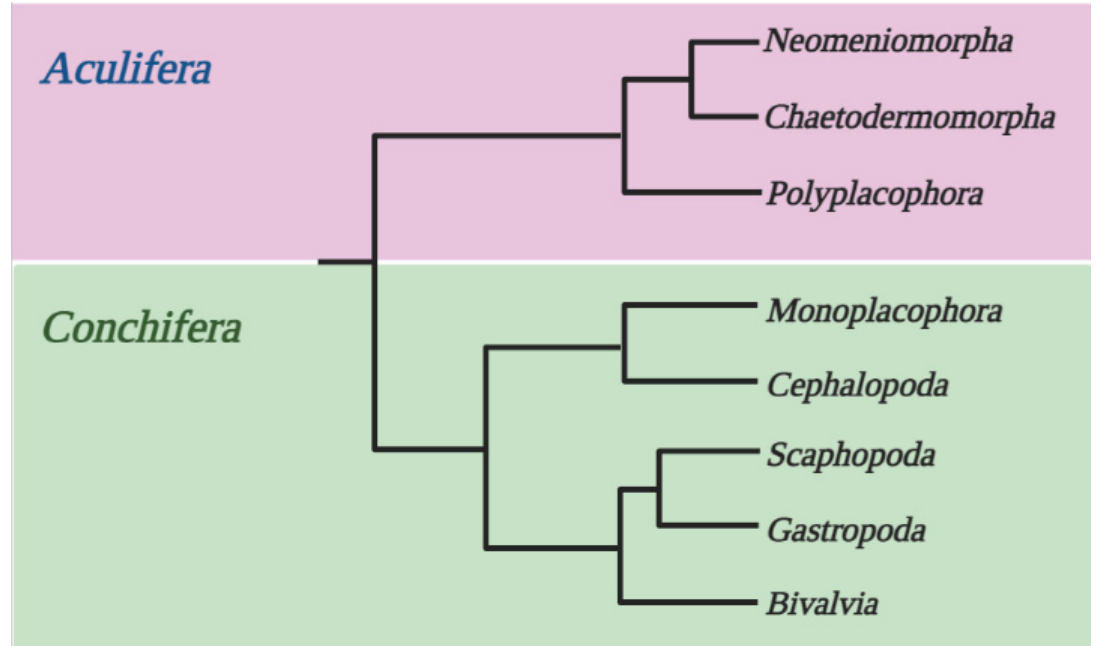
Figure 10. Current understanding of Mollusca phylum taxonomy (adapted from [56] by BioRen- der.com (2022)).